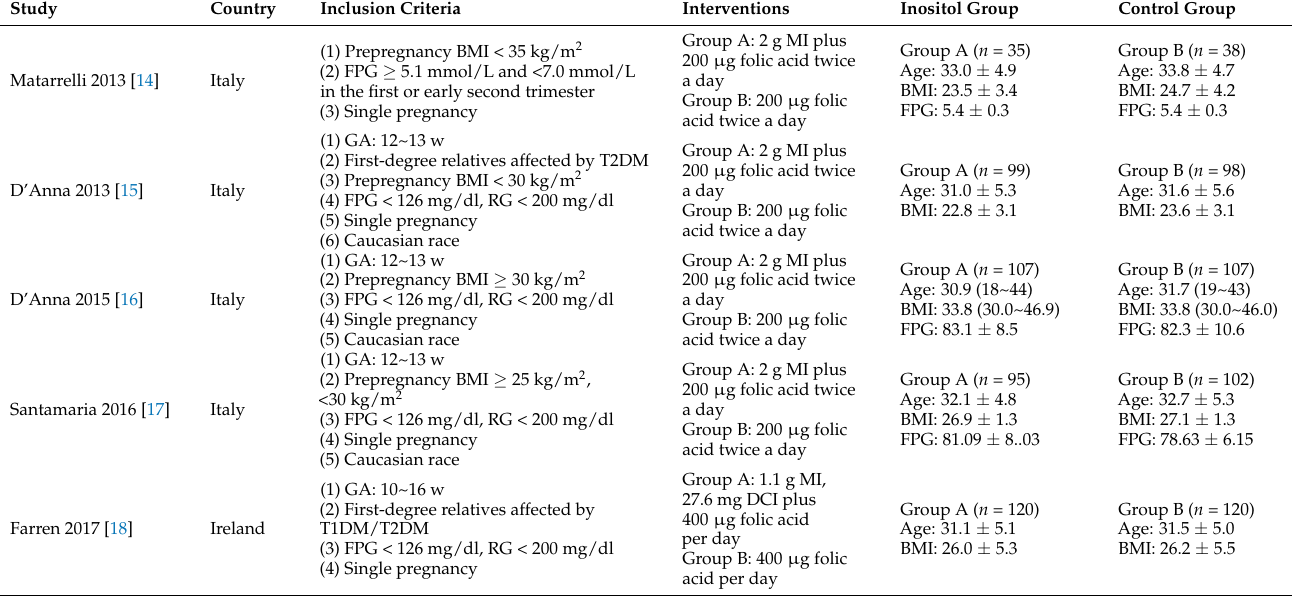
Table 1. The main characteristics of the included studies. BMI: body mass index. GA: gestational age. FPG: fast plasma glucose. RG: random